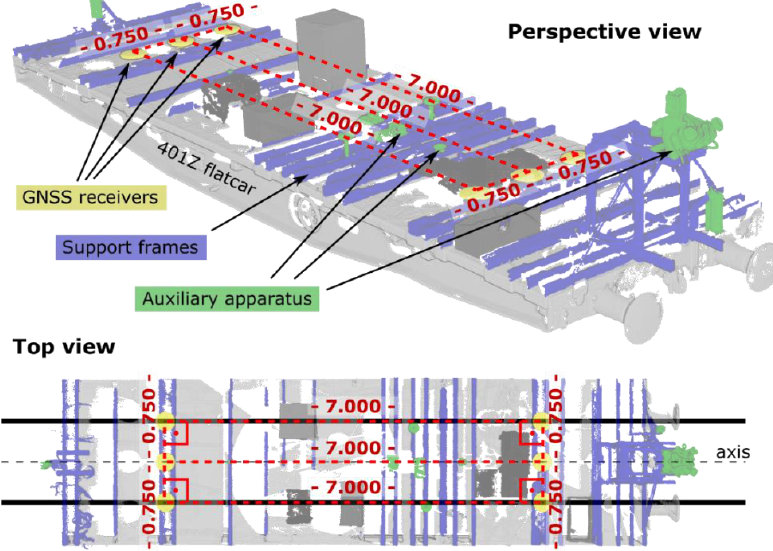
Figure 1. Configuration of six GNSS receivers on the railway platform.